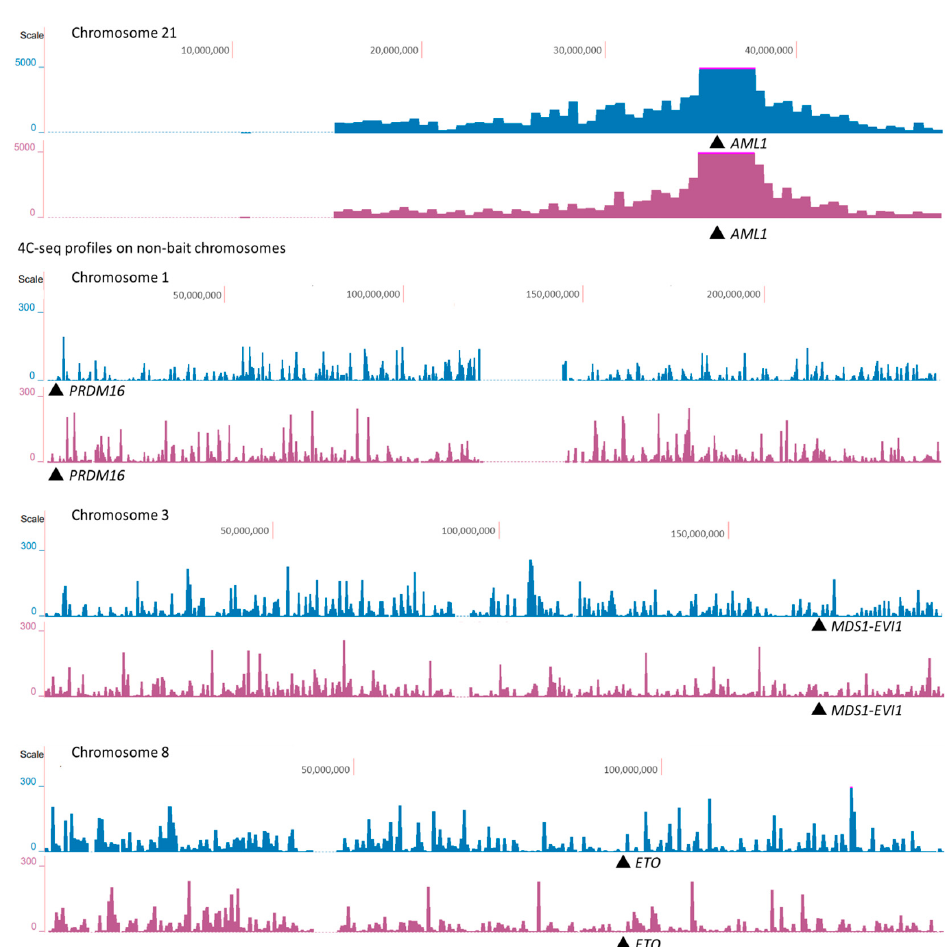
Figure 4. 4C-seq profiles of AML1 from untreated cells (blue) and from cells treated with etoposide (byzantium). The 4C-seq profiles of AML1 on chromosome 21 show cis -contacts (first pair of rows), and the 4C-seq profiles of AML1 on chromosomes 1, 3, and 8 show AML1 trans -contacts with chromosomes that bear AML1 translocation partners in TI-related AML (other pairs of rows). AML1 translocation partner genes are indicated by arrows. Data resolution is 500 kb. 4C-seq data are collected in Table S3.